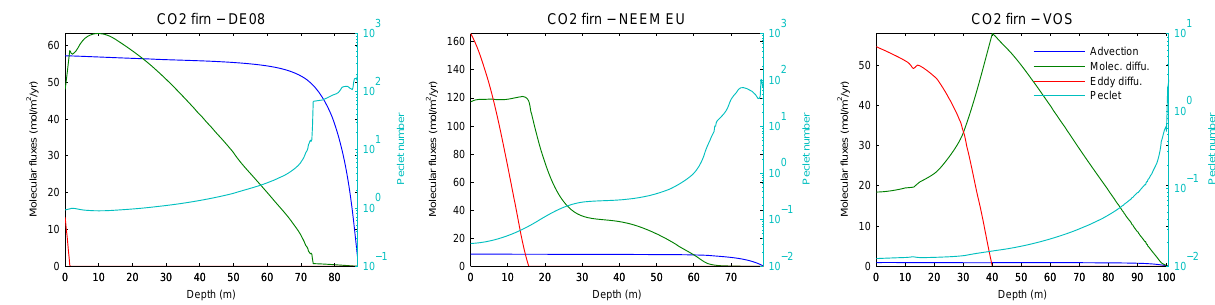
Fig. 2. Relative importance of diffusion and advection for CO 2 transport in 1990: molar flux due to advection and firn sinking (blue), molar flux due to molecular diffusion (green), molar flux due to eddy diffusion (red) and P´eclet number